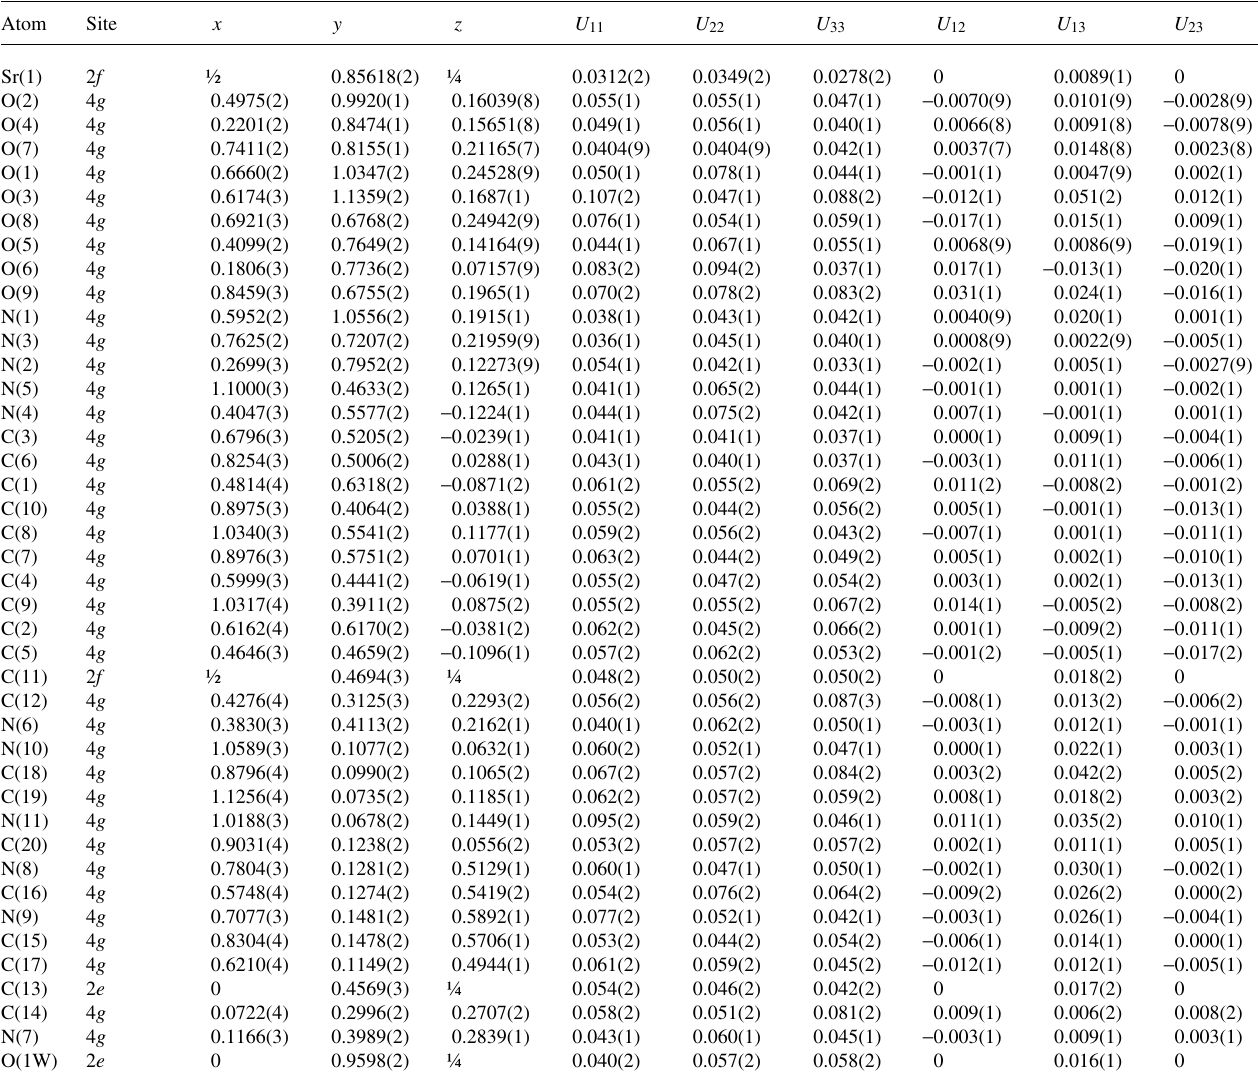
Table 3. Atomic coordinates and displacement parameters (in Å 2 ) .